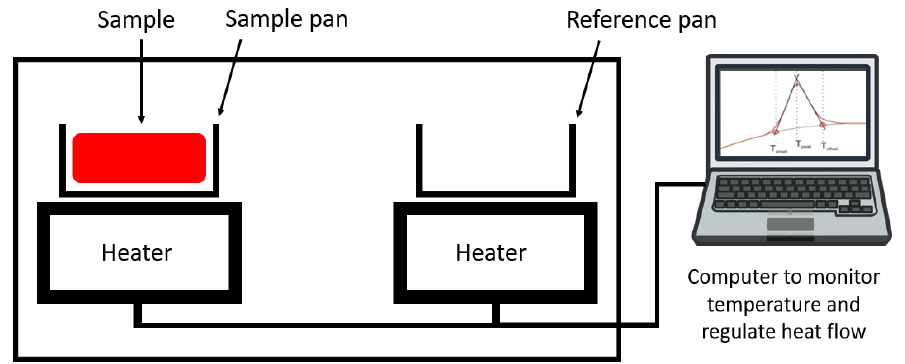
Figure 2. Schematic equipment for DSC analyses and typical DSC curve.